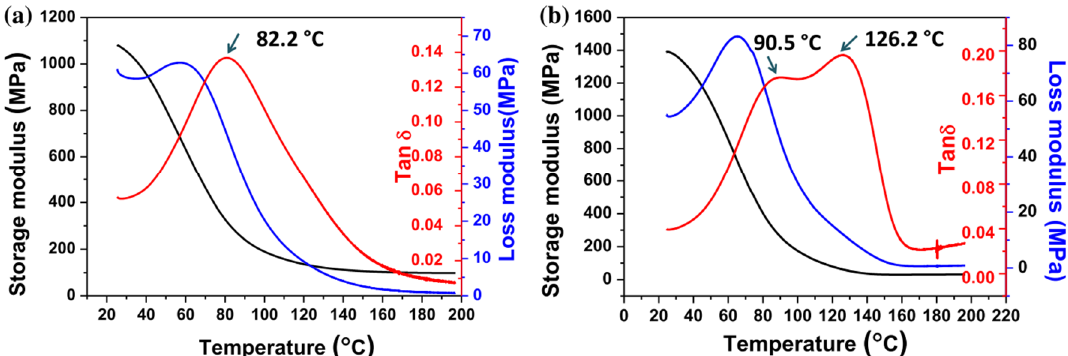
Figure 12. DMA results of the printed samples from ( a ) pure photopolymerization system and ( b ) photo-thermal dual-curing system. Reproduced from [68] with permission from Springer.